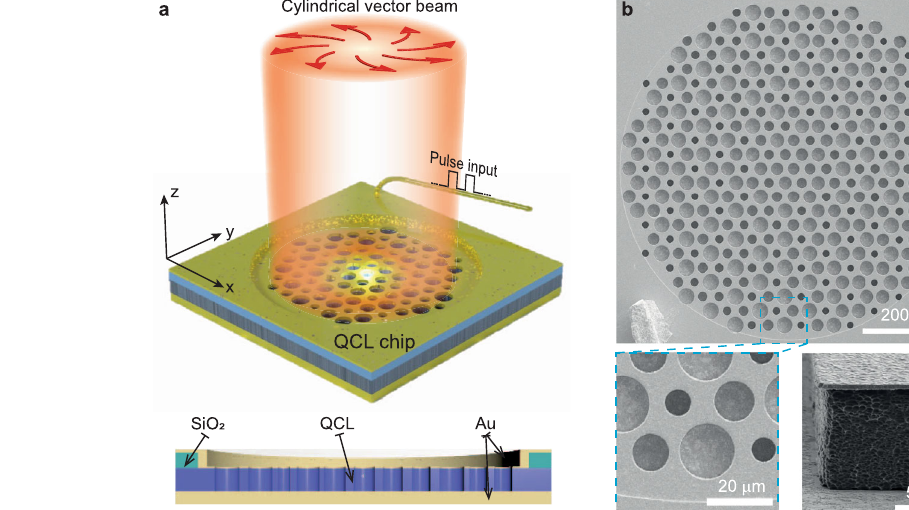
cavity is insulated by a SiO 2 layer so that it is unpumped. b SEM image of a fabri- catedsample,whichhaslatticeconstant a =30 μ m,windingnumber w = +1,vortex core radius ξ =2 a , and an overall device radius of six periods. The side view of the SEM shows that the QCL is undercut relative to the top Au